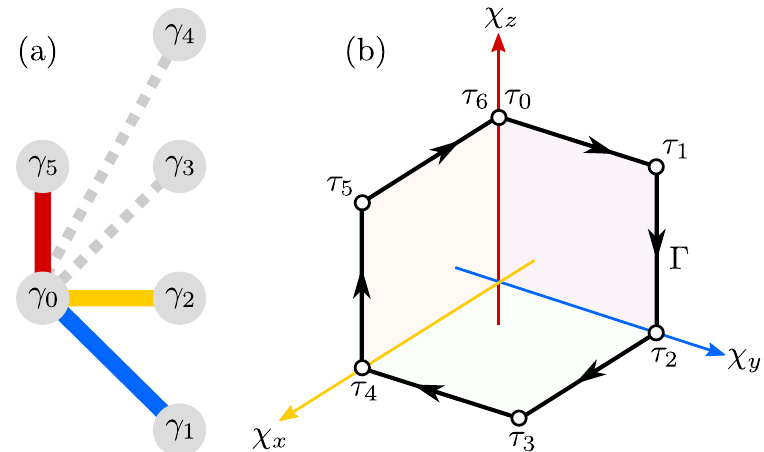
Figure 1: (a) Sketch of a single Majorana qubit consisting of six MZMs. They are connected by five lines representing the five pair-wise couplings P which enter the 0 j qubit Hamiltonian in Eq. (5). In the idle configuration, only Majoranas γ and γ are 0 5 coupled (thick red line), leaving the other four Majoranas at zero energy. The holo- nomic braiding of MZMs γ and γ requires the additional manipulation of couplings 1 2 P and P (blue and yellow line, respectively). (b) The closed loop Γ ( t ) followed by 01 02 the three coupling strengths χ , χ and χ specified in Eq. (7) during the clockwise x y z ) , which are listed in Tab. 1, braiding of MZMs γ and γ . The "anchor points" Γ ( τ j 1 2 are highlighted with small